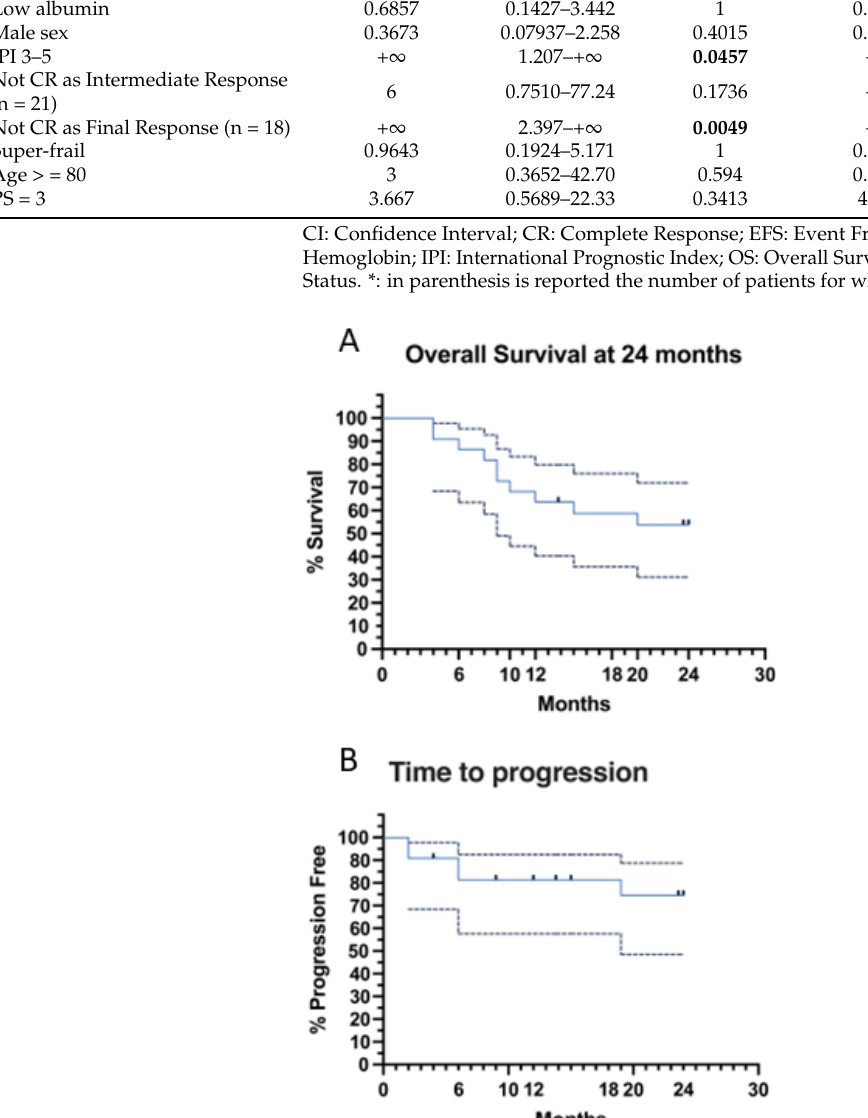
Table 3. Univariate analysis for OS, EFS and PFS of several risk factors.